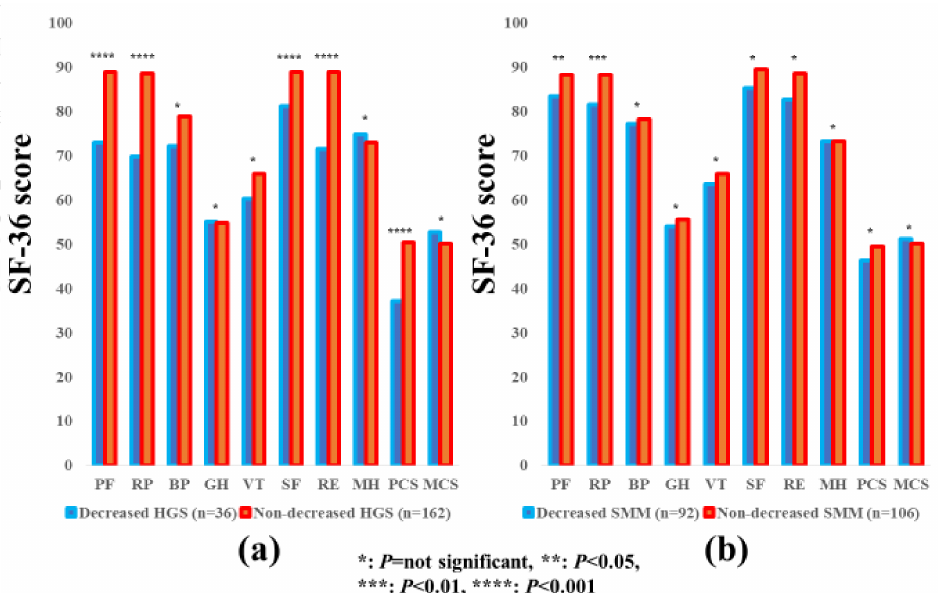
Figure 4. The SF-36 scores across 10 items in the decreased and non-decreased HGS groups ( a ), and the decreased and non-decreased SMM groups ( b ) in male patients ( n = 198). The average scores in each item of the SF-36 were plotted.